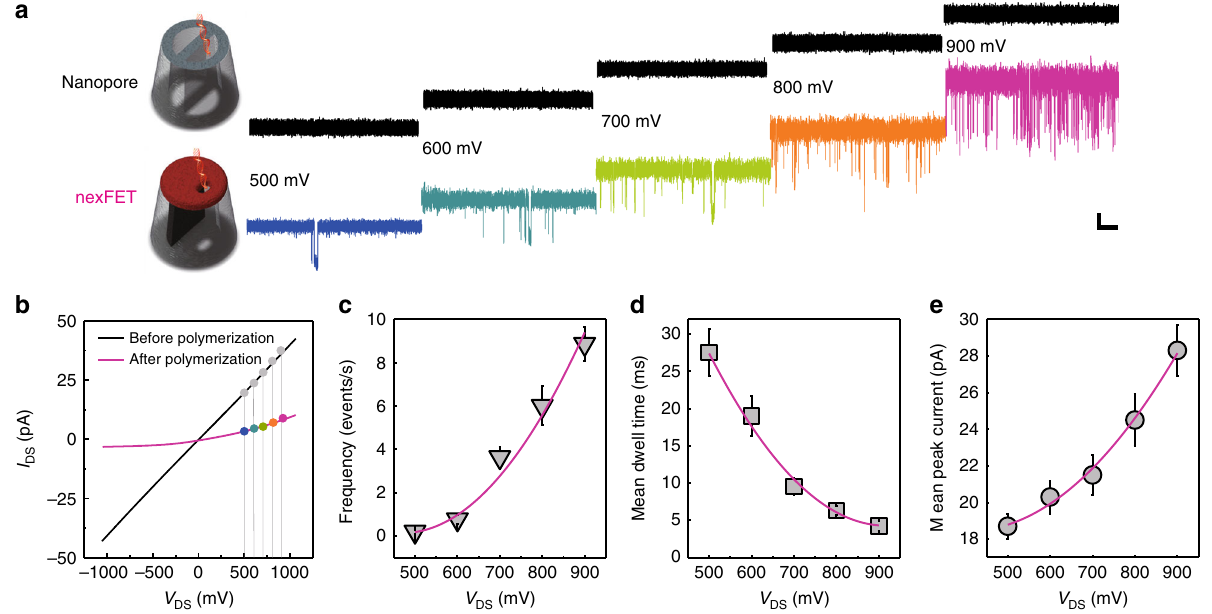
Fig. 3 dsDNA translocation behavior through an unmodi fi ed and PPy-coated quartz nanopipette. a Nanopore detection of 100pM 3kbp dsDNA in 100mM KCl and a 1mM Tris-EDTA buffer, pH 7 for a quartz nanopipette with a nanopore size of approximately 100nm ( top ) and nexFET ( bottom ). Each trace is 10s long and fi ltered using a low-pass Bessel fi lter with a cut-off frequency of 10KHz ( scale bar : vertical 10pA, horizontal 1s). b No events are observed in unmodi fi ed nanopipette ( black traces in a ), due to the large nanopore size as can be seen from the I-V curves before and after polymerization. The nexFET with no applied V G bias behaves in a very similar manner to a conventional nanopore with c increasing event frequency, d decreasing mean dwell times, and e increasing mean peak currents as the voltage is increased. Error bars represent the standard deviation of three independent experimental repeats with different